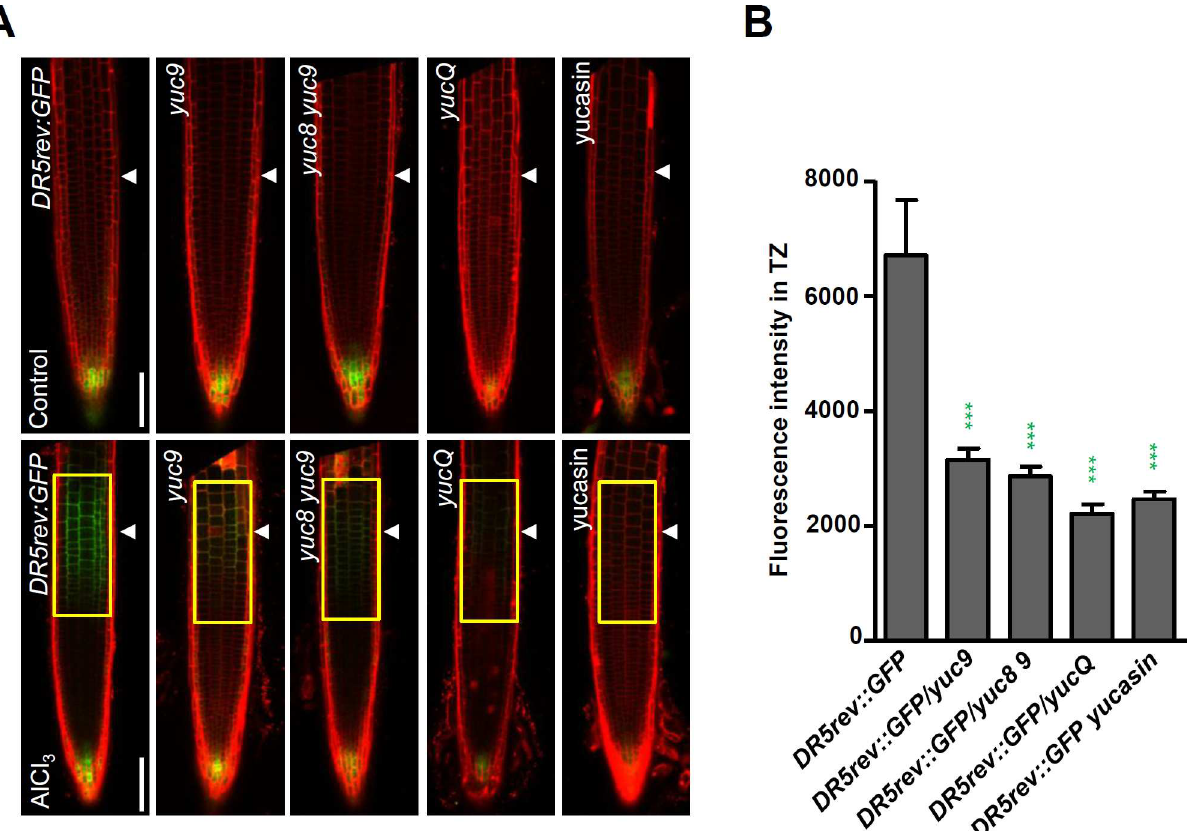
Fig 2. YUCs regulate Al induced local auxin response in root TZ. (A) Five-day old DR5rev : GFP , DR5rev : GFP/yuc9 , DR5rev : GFP/yuc8 yuc9 and DR5rev : GFP/yucQ seedlingswere exposed or not (control) to 25 μ M AlCl 3 for two hours. Four-day old transgenic DR5rev : GFP seedlingswere pre-treated with 10 μ M yucasin for 1 day, then were co-treated with 25 μ M AlCl 3 for two hours or not (control). The upper row shows expression of DR5rev : GFP , DR5rev : GFP/yuc9 , DR5rev : GFP/yuc8 yuc9 and DR5rev : GFP/yucQ controls while the lower row shows the expressionof these transgenic seedlings exposed to 25 μ M AlCl 3 . Cell boundariesappear red following propidiumiodide staining. The root-apex TZ is marked by white arrowheads. Scale bar: 100 μ m. (B) Quantification of the Al-induced fluorescence intensity in the TZ of DR5rev : GFP , DR5rev : GFP/yuc9 , DR5rev : GFP/yuc8 yuc9 , DR5rev : GFP/yucQ and 10 μ M yucasin pre-treated DR5rev : GFP seedlings(around 30 seedlingswere measured in each material). The detected fluorescence region in TZ is marked by yellow rectangles. Cell boundaries appear red followingpropidiumiodide staining. The TZ is marked by white arrowheads.Statistical differencefrom detected fluorescence is indicated by asterisks (Fisher’s exact test, *** P < 0.001).